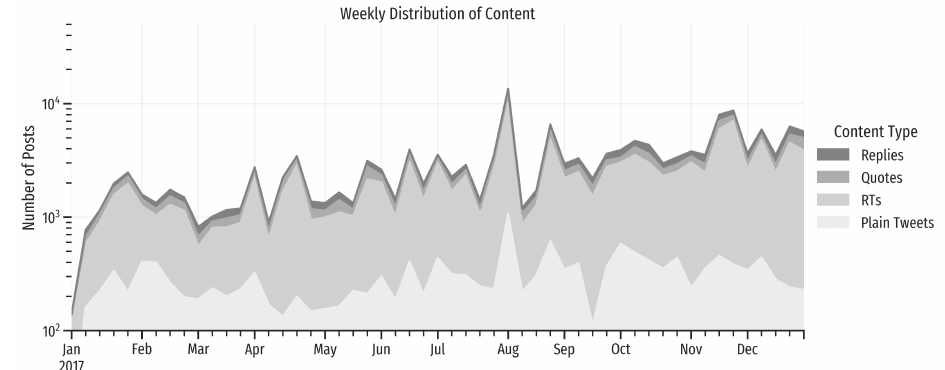
Figure 2. Weekly volume of content in the dataset, disaggregated by type of content/interaction.